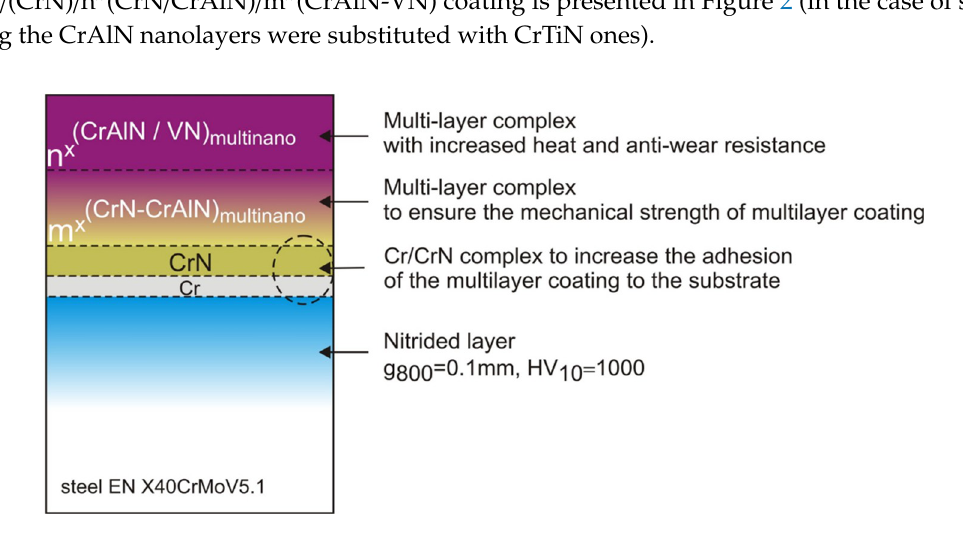
Figure 2. Scheme of multilayers arrangement in Cr/(CrN)/n x (CrN/CrAlN)/m x (CrAlN/VN) coating.